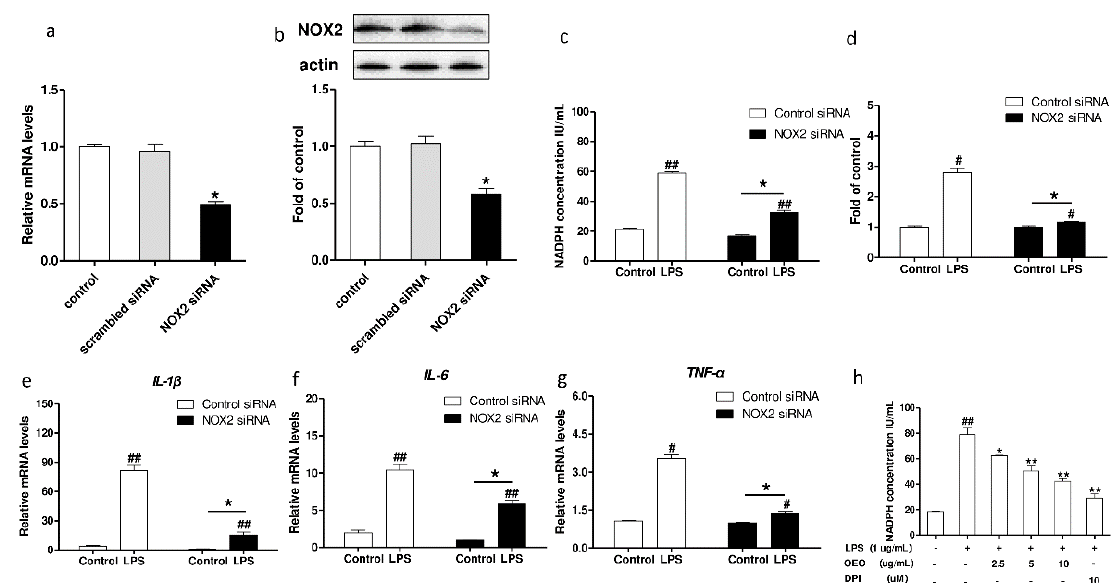
Figure 4. Effect of nicotinamide adenine dinucleotide phosphate (NADPH) oxidase 2 (NOX2) silencing on LPS-induced ROS production and inflammatory cytokines mRNA expression in RAW264.7 cells . ( a , b ) RAW264.7 cells were treated with NOX2-siRNA or control siRNA, and incubated for 24 h. ( a ) NOX2 mRNA expression levels were measured using RT-PCR. ( b ) NOX2